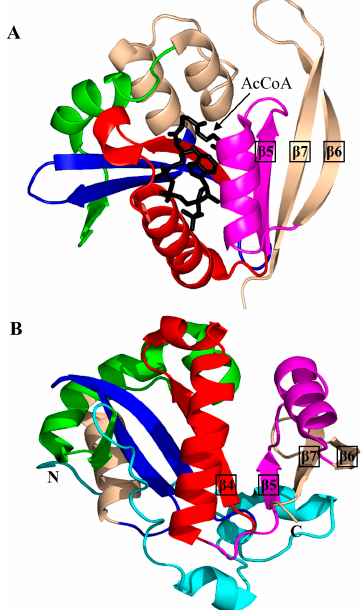
Figure 14. Cartoon representation of the structure of N ε -lysine protein acetyltransferase. ( A ) Pseudomonas aeruginosa PA4794 in complex with AcCoA (PDB ID: 3PGP [137]); and ( B ) Rv1347c of M. tuberculosis (PDB IS: 1NYK3 [138]). The conserved and non-conserved motifs of the GNAT domains are colored as in Figure 3.